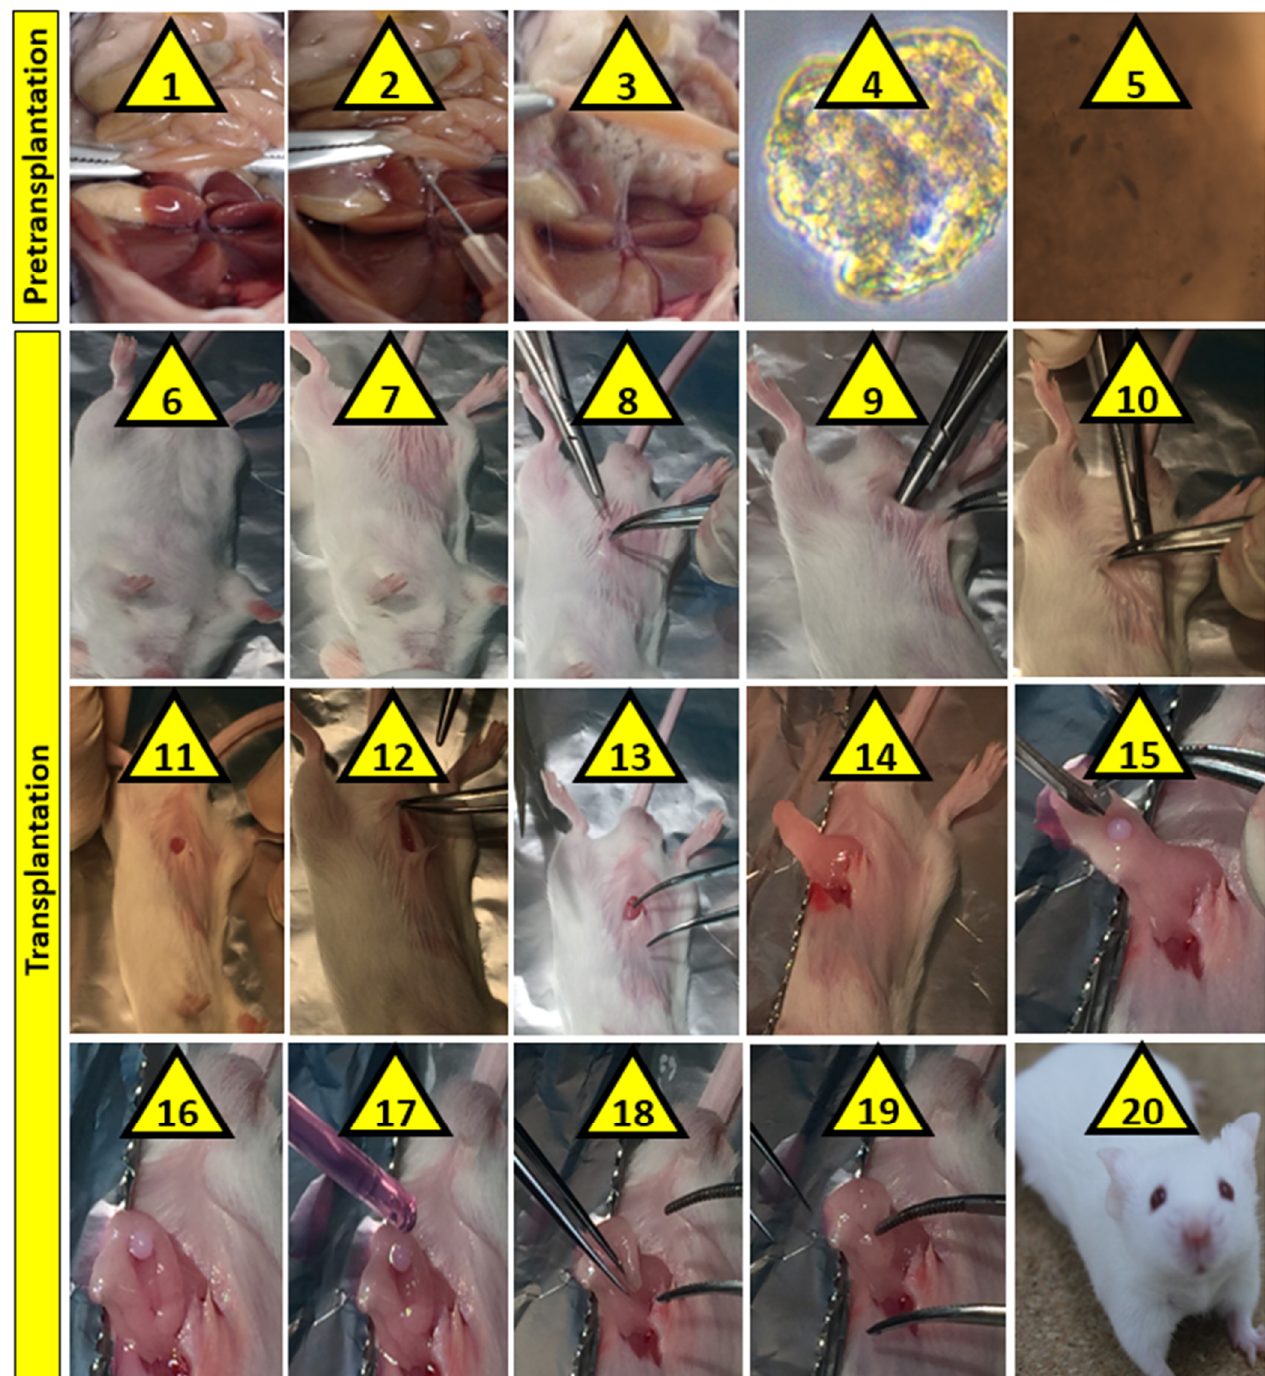
Figure 1. An illustration surgical figure: (1) location of the common bile duct, (2) injection of collagenase into the common bile duct, (3) perfusion and separation of the pancreas, (4) extracted and purified islets, (5) PB-impregnated microencapsulated islets used for transplantation, (6–14) creation of an omentum pouch for transplantation, and (15–20) transplantation and mouse recovery.